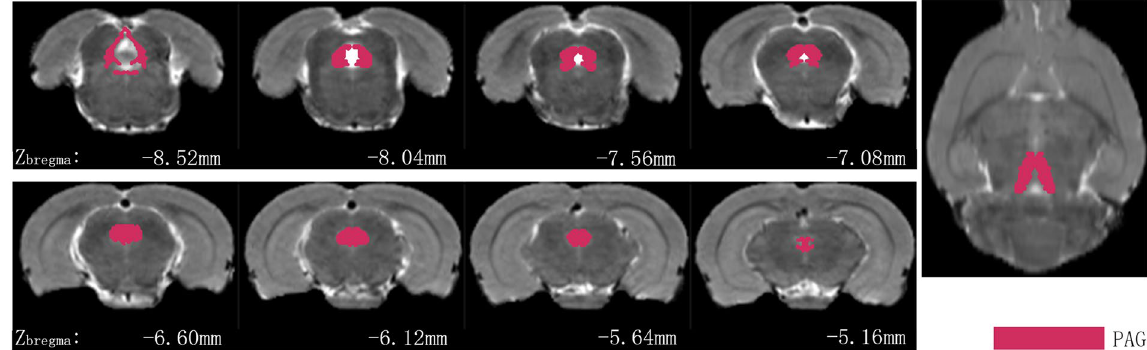
Figure 4. Periaqueductal gray (PAG) seeds across the rats imposed on the T2-weighted MRI template and on the rat atlas structures. The anatomical boundaries for each rat were based on the atlas of Paxinos and Watson 40 . The coronal slices of the PAG are shown in the left two rows, and the right image shows the axial slice of the PAG.